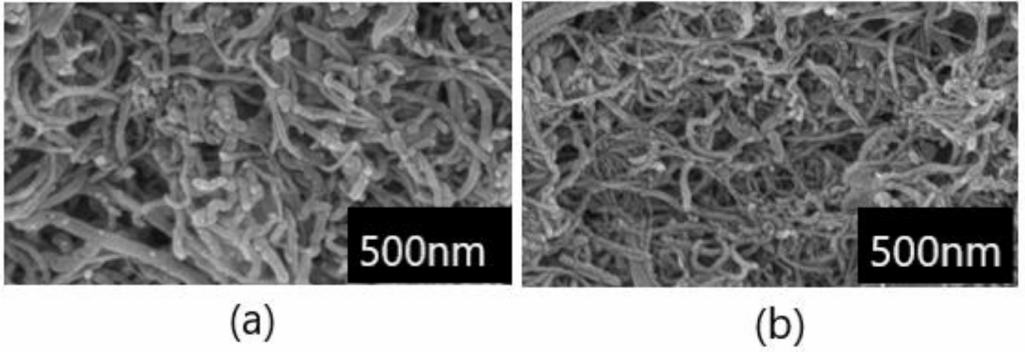
Figure 1. The scanning electron microscope (SEM) micrograph of carbon nanotubes network. The upper surface of entangled carbon nanotube network prepared by the filtering method from multiwalled carbon nanotubes (MWCNTs; pure) and oxidized MWCNTs (KMnO 4 ). ( a ) SEM micrograph of the MWCNTs (pure). ( b ) SEM micrograph of MWCNTs (KMnO 4 ).